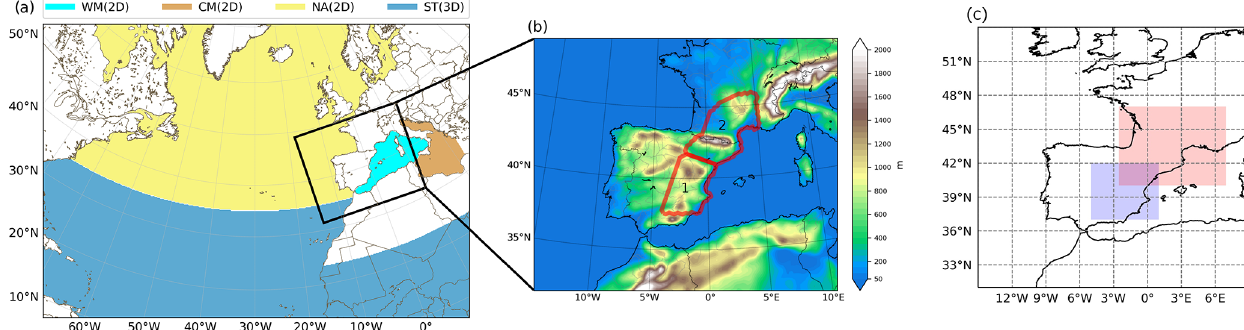
Figure 1. (a) Moisture sources considered: western Mediterranean (cyan), central Mediterranean (brown) and North Atlantic (yellow) 2D sources; and tropical and subtropical 3D source(blue). (b) Regions most affected by the October (1) and November (2) events (original figure from Insua-Costa et al., 2019). (c) FLEXPART-WRF particle selection areas for the October (blue) and November (red) events.